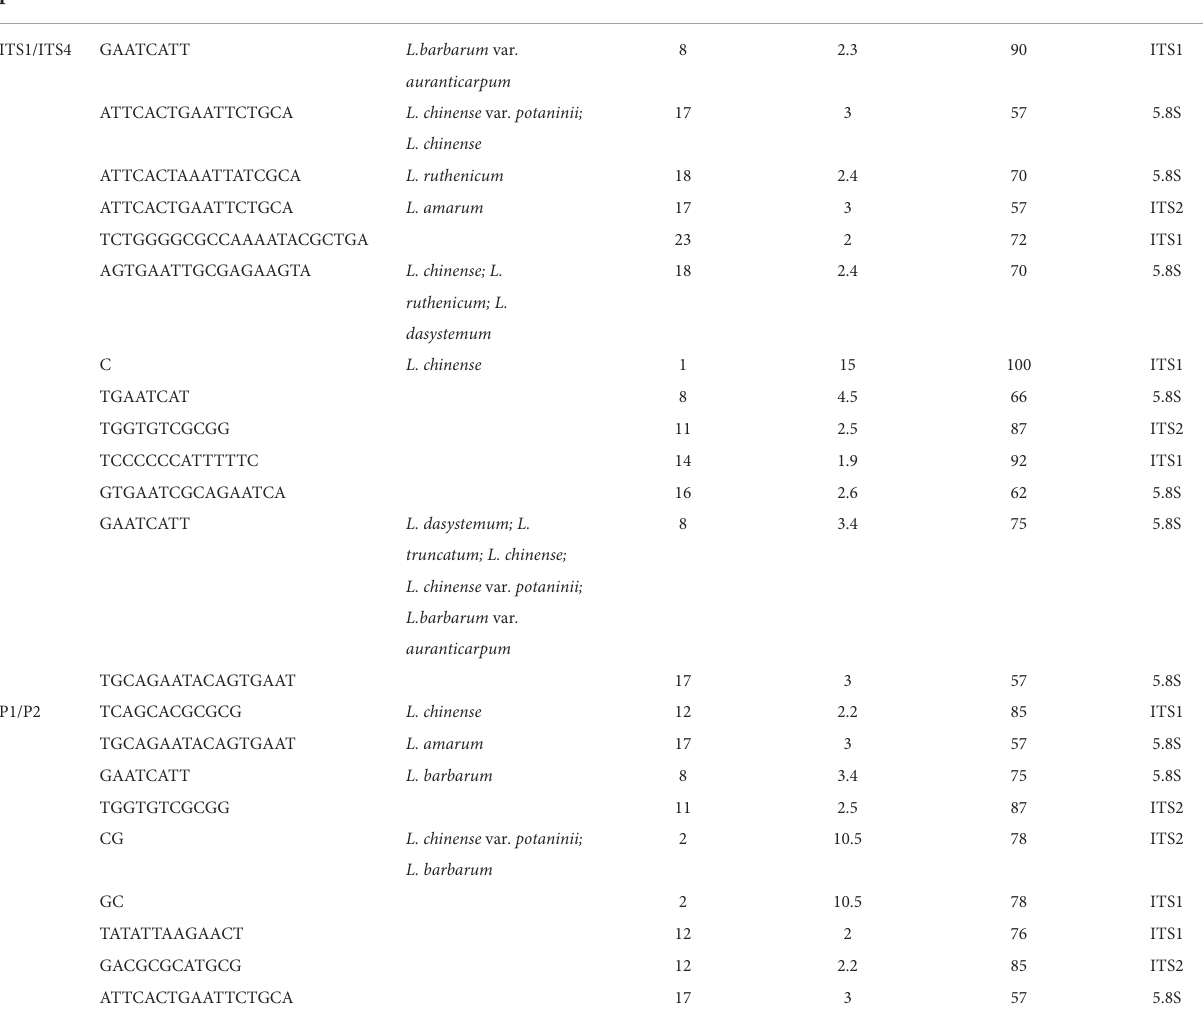
TABLE 1 Tandem repeats found among ITS sequences in Lycium . Primer